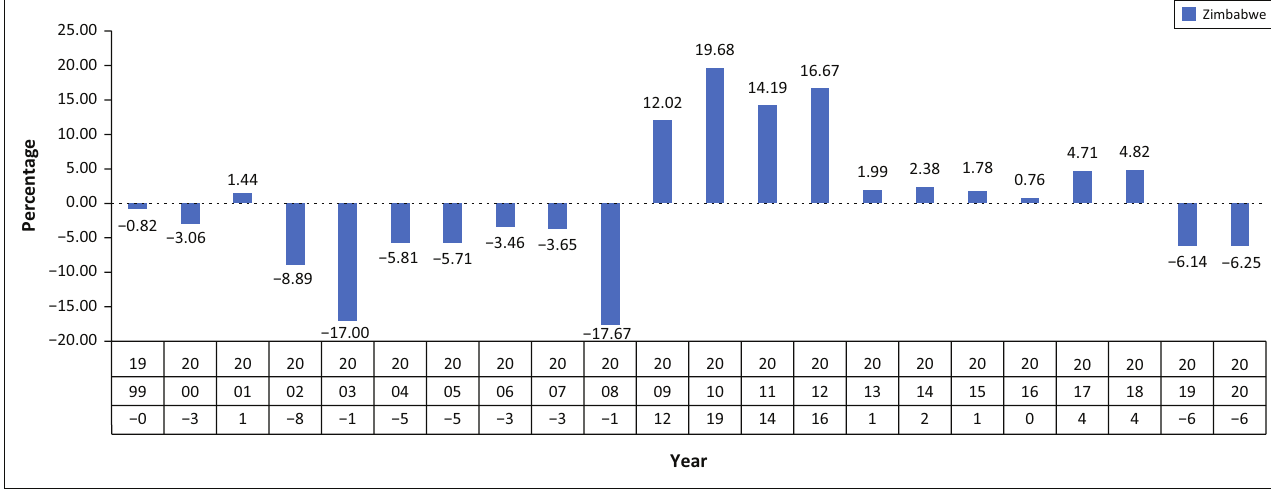
FIGURE 4: Real gross domestic product annual percentage growth rate in Zimbabwe.